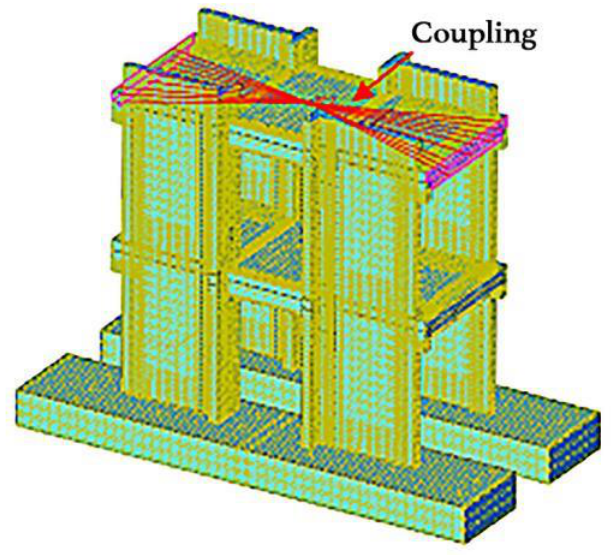
Figure 4. Simulation of cyclic loading history.